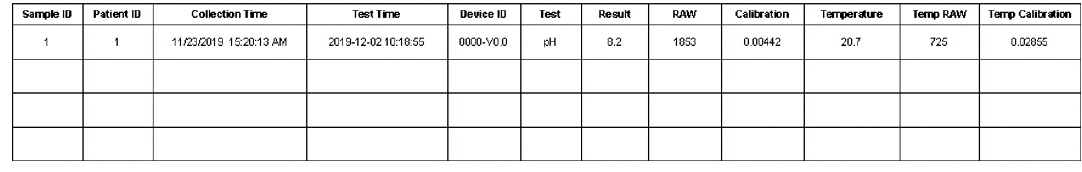
Figure 16. Representative table of samples.